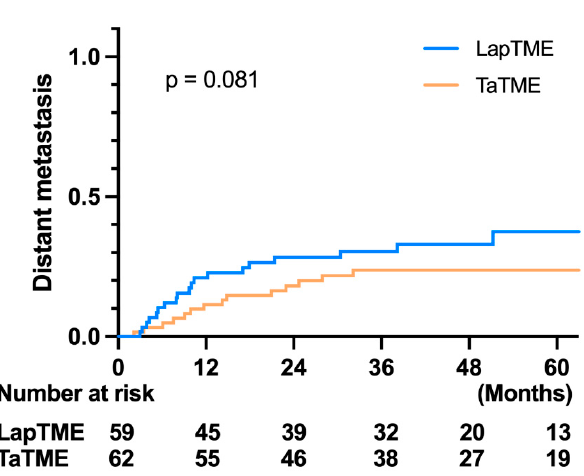
Cancers 2022 , 14 , x FOR PEER REVIEW Figure 5. Kaplan–Meier survival curves of DM between the TaTME and LapTME groups.